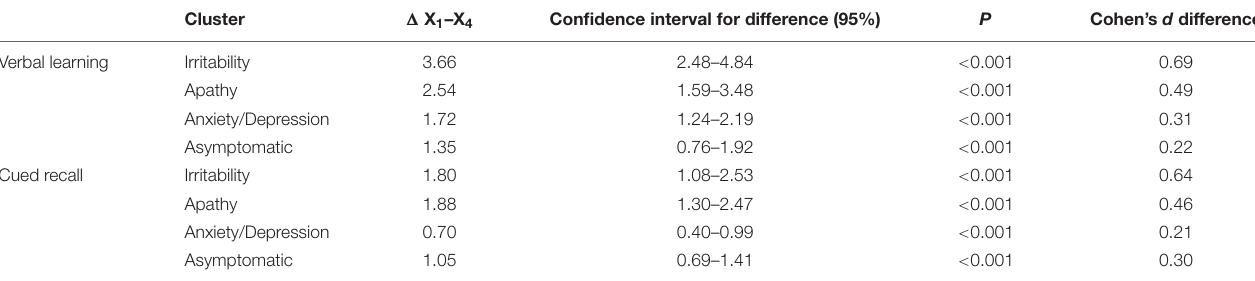
TABLE 3 | Simple effects and effect sizes of significant cognitive domains (i.e., verbal learning and cued-recall) between baseline (X 1 ) and third follow-up (X 4 ) measures.